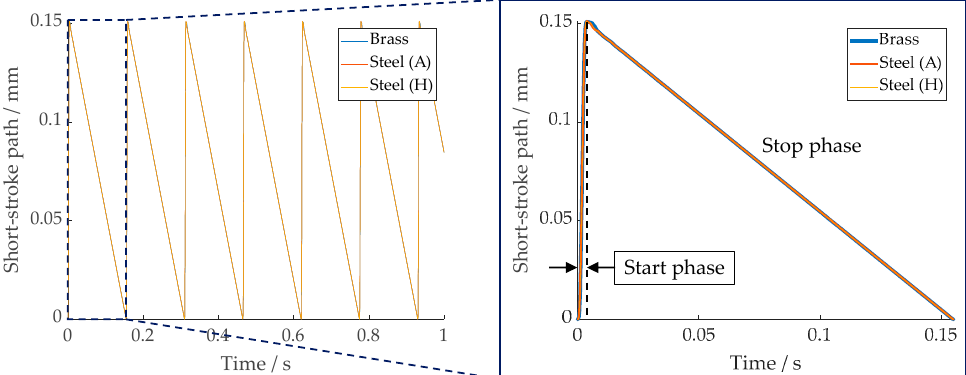
Figure 7. Alternating movement of the tool drive system during machining of brass, soft annealed steel (A), and hardened steel (H) with a dwell value of n v = 1.5 .